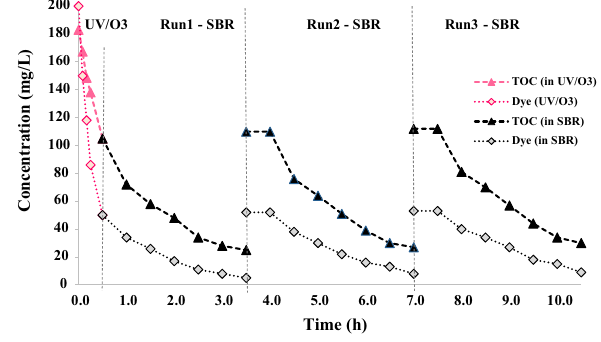
Fig. 6 The RR-198 discoloration and TOC removal rates with UV/ O 3 pretreatment in the SBR biological system, [RR-198]: 200 mg/L, O 3 = 40 mg/L min, MLSS = 3500